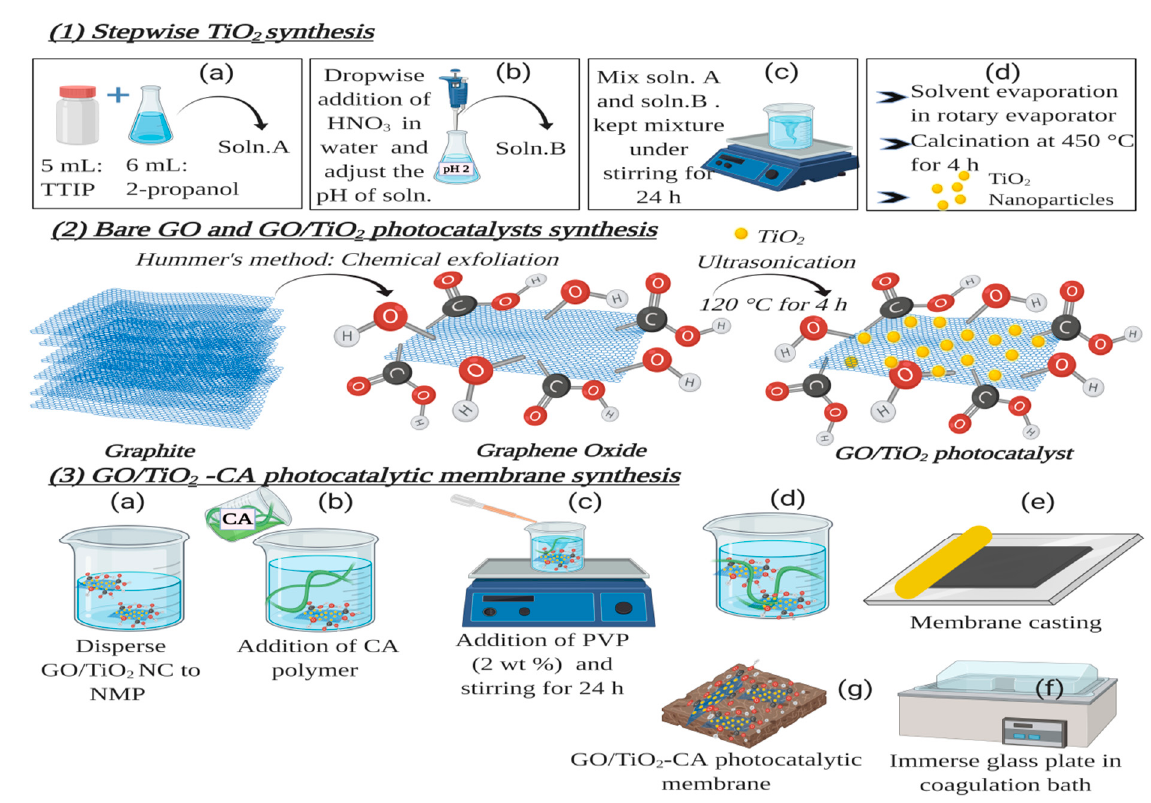
Figure 1. Synthesis schemes ( 1 ) TiO 2 synthesis ( 2 ) Bare GO and GO/TiO 2 synthesis ( 3 ) GO/TiO 2 -CA photocatalytic mem- brane synthesis.